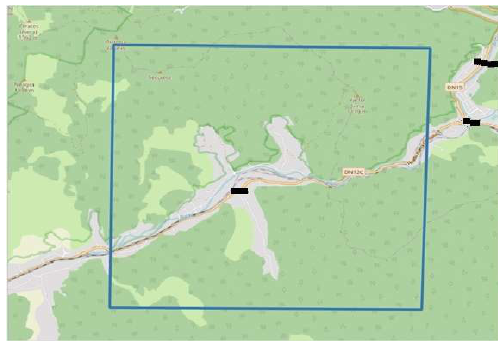
Figure 12. Area of interest (analyzed area) (QGIS).